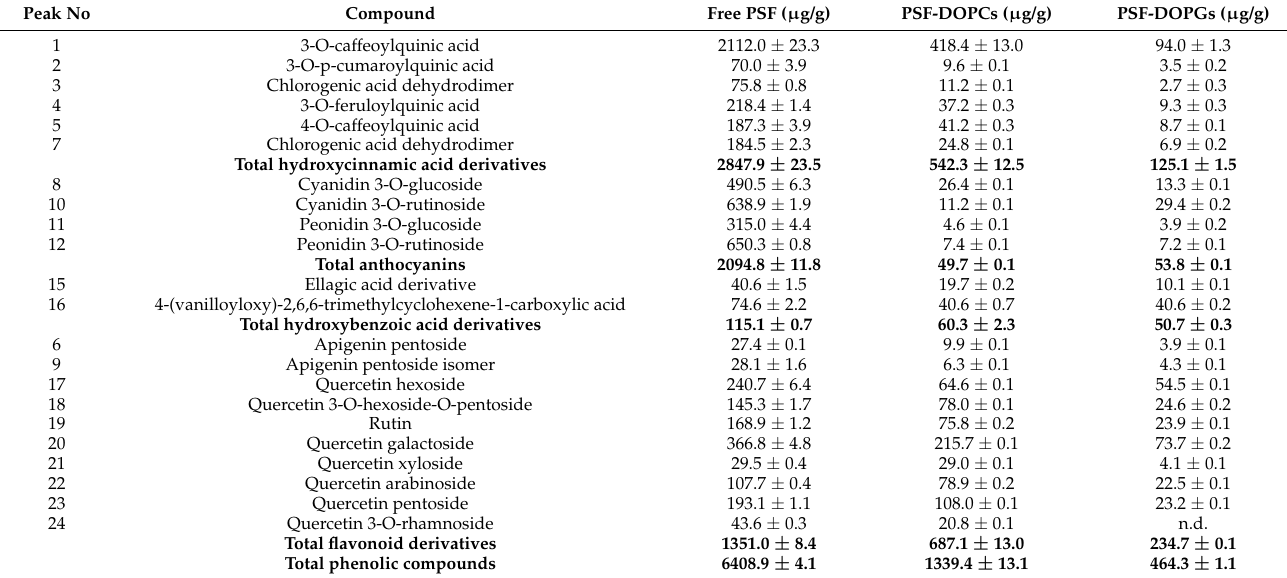
Table 1. The total concentration of phenolic compounds in P. spinosa fruit ethanolic extract (free PSF) and in extract-loaded vesicles (PSF-DOPCs and